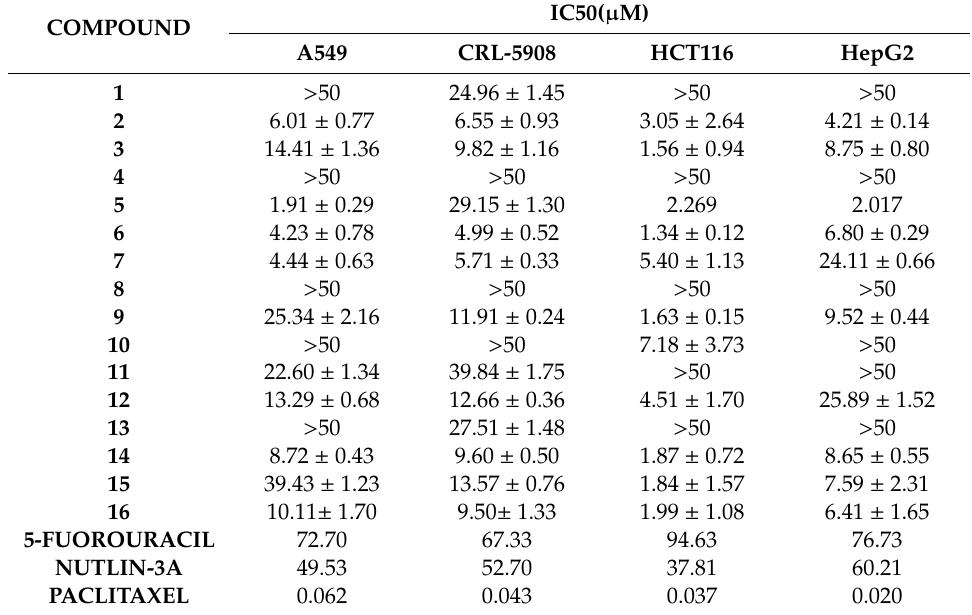
Table 1. The in vitro antiproliferative activities of the synthesized compounds a .